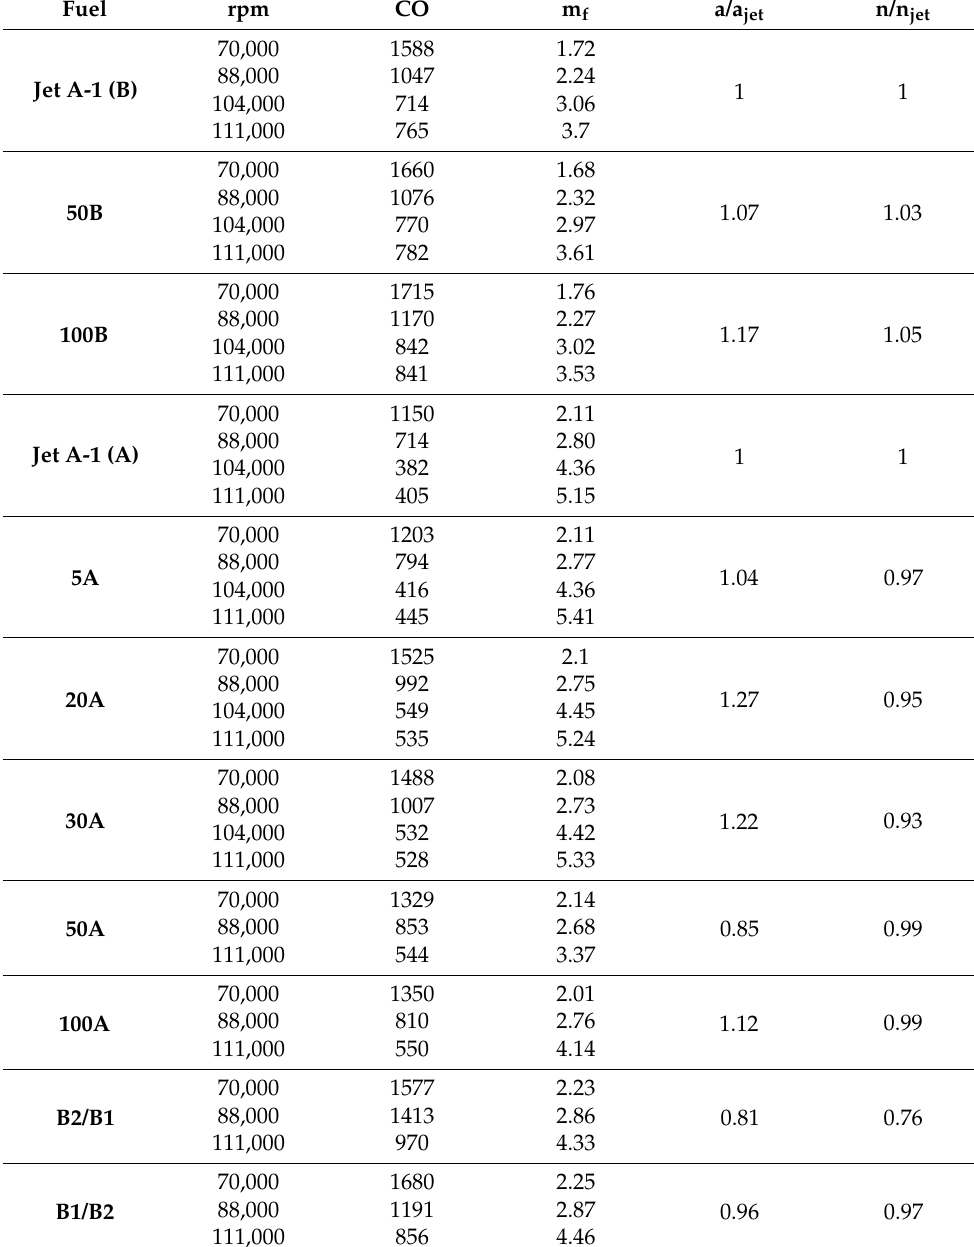
Table 3. Empirically determined values of the a and n parameters of the CO = a m fn dependence; the “jet” index refers to a and n value obtained for the Jet A-1 fuel appropriate for a given sample batch, marked in the table with